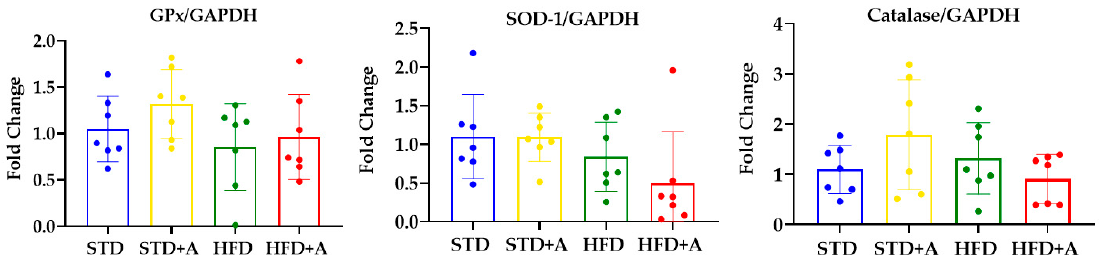
Figure 7. Alliin effect on antioxidant enzymes gene expression. Glutathione peroxidase, superoxide dismutase, and catalase gene expression in the liver of DIO mice was not modified by alliin treatment. STD, standard diet group; STD + A, standard diet + alliin treatment group; HFD, high-fat diet group; HFD + A, high-fat diet + alliin treatment group. For gene expression, each sample 2 - ∆∆ CT was calculated and analyzed by one-way ANOVA / Tukey’s test. Results expressed as mean ± SD.